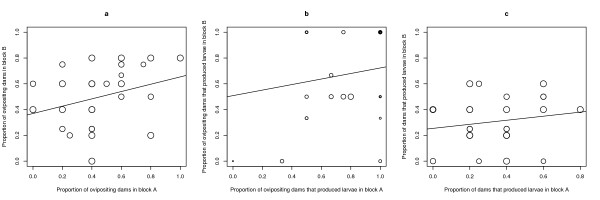
Scatter plots of male fitness traits 1, 2 and 3. Scatter plots of 27 sire families in blocks A and B for (a) the proportion of ovipositing dams (r = 0.32, df = 25, p = 0.102), (b) proportion of ovipositing dams that produced larvae (r = 0.42, df = 22, p = 0.040) and (c) proportion of dams that produced larvae (r = 0.17, df = 25, p = 0.383). The sizes of the data points are proportional to the geometric mean of the number of dams in the denominator of the trait of interest in blocks A and B. Shown are the lines of best fit.